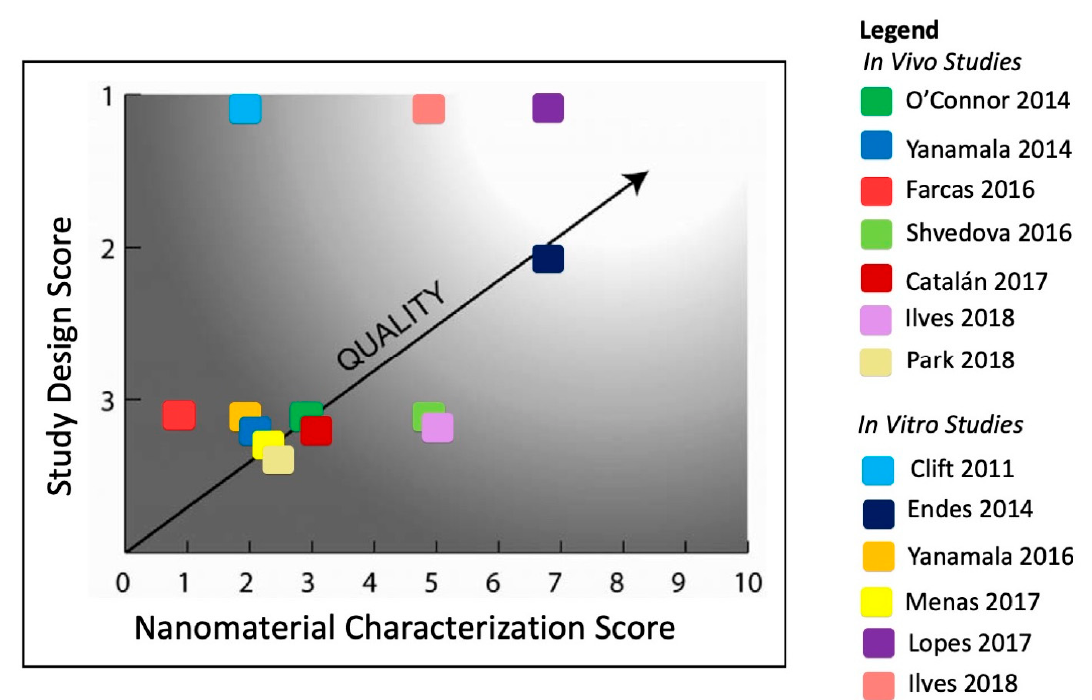
Figure 1. A schematic assessment of the overall quality of CN inhalation studies for risk assessment purposes based on its study design score and nanomaterial characterization score. The clear area represents a range of scores for which a study can be considered of high overall quality; conversely, the shaded area represents studies of low overall quality (adapted from Card and Magnuson, 2010